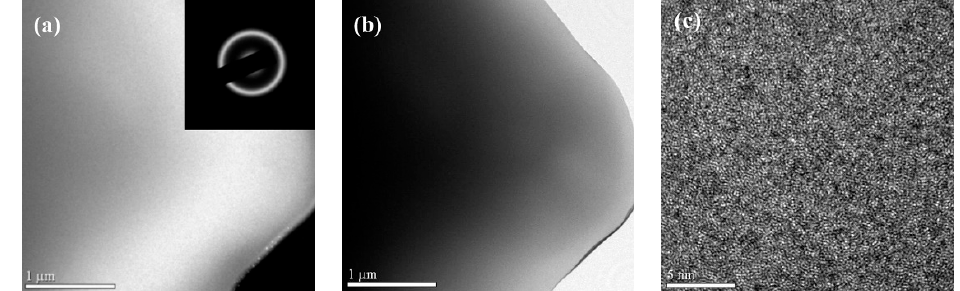
Figure 7. ( a ) Dark-field image of (TiZr) 0.5 (Ni 0.6 Cr 0.1 V 0.1 ) 2.1 ribbon with a speed of 45 m/s and its corresponding SAED pattern in inset; ( b ) bright-field TEM; and ( c ) high resolution TEM images of (TiZr) 0.5 (Ni 0.6 Cr 0.1 V 0.1 ) 2.1 ribbons.